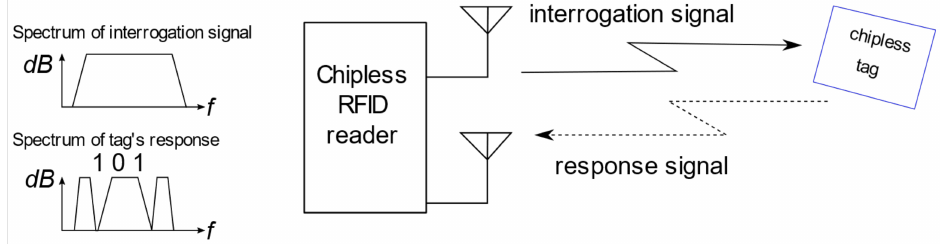
Figure 1. Principle of the frequency-encoding chipless RFID